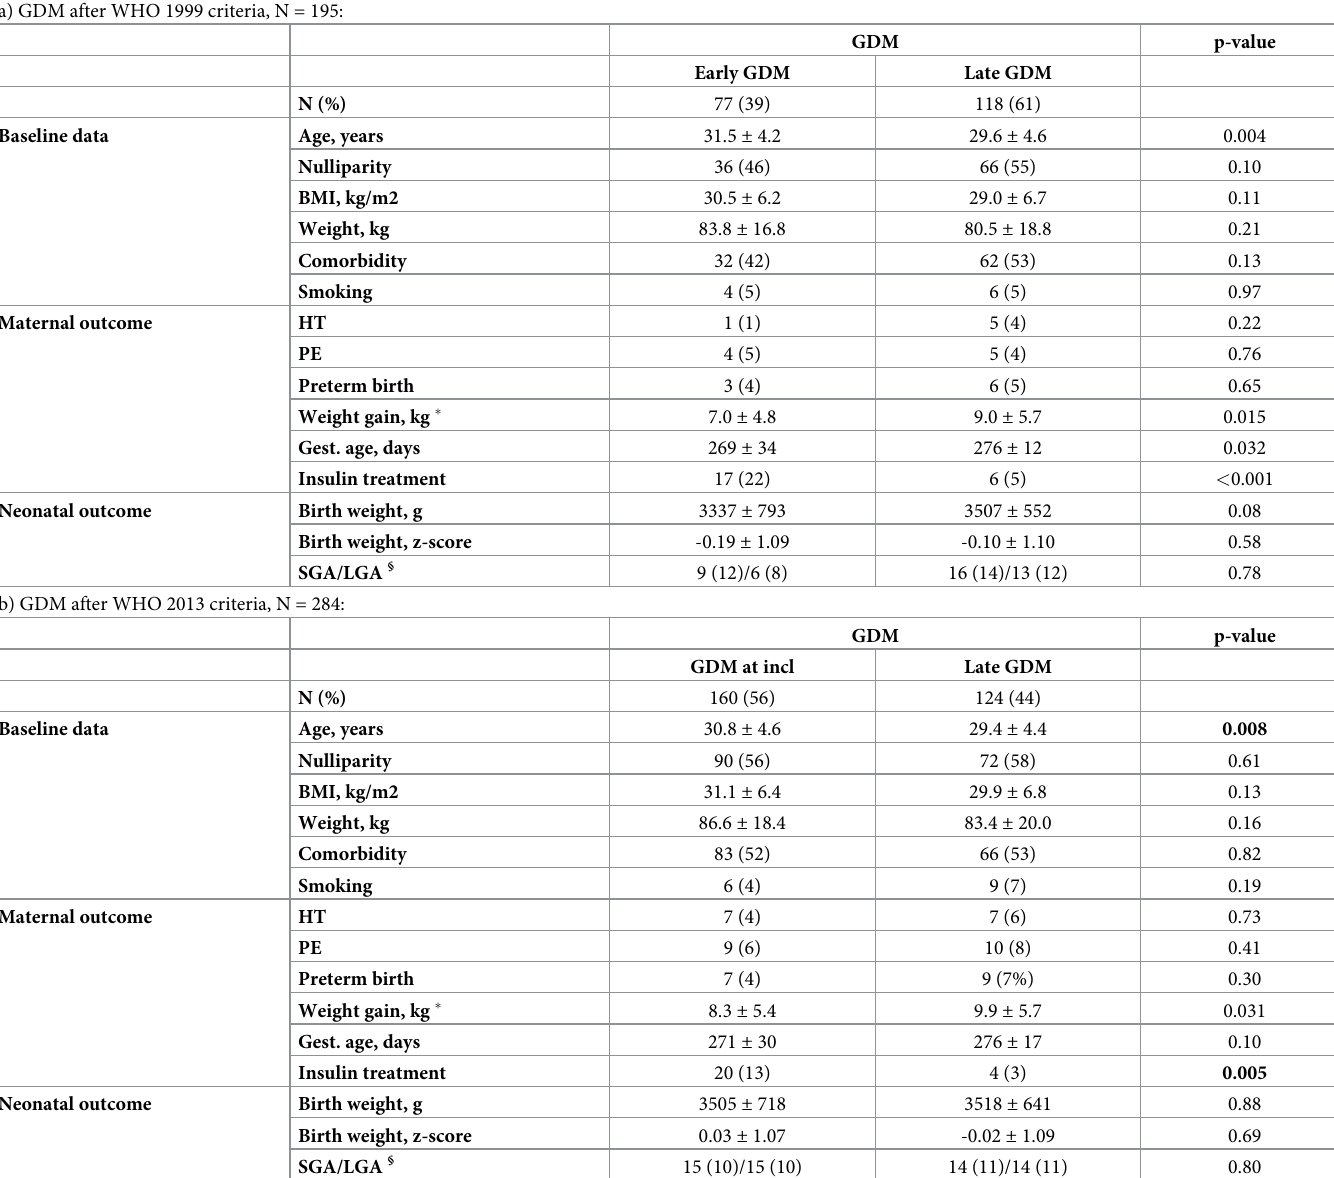
Table 4. GDM diagnosed at inclusion (in first trimester) compared to GDM diagnosed later in pregnancy. a) GDM after WHO 1999 criteria, N = 195. b) GDM after WHO 2013 criteria, N =